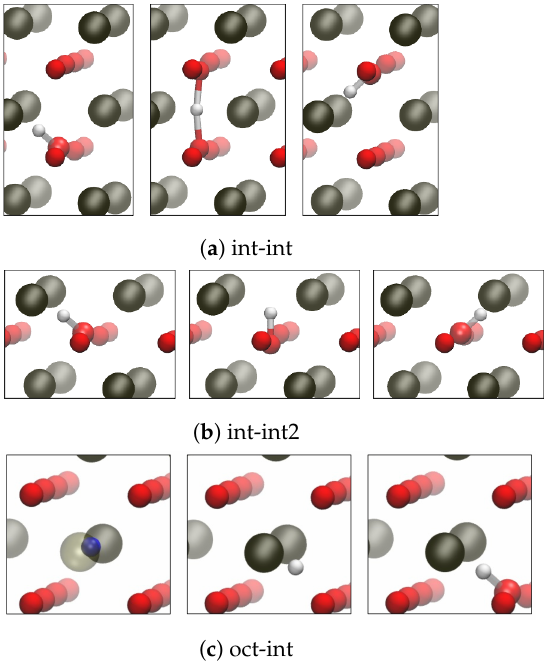
Figure 2. Hydrogen diffusion pathways investigated in this study. The hydrogen in the octahedral site in ( c ) is colored blue for the sake of